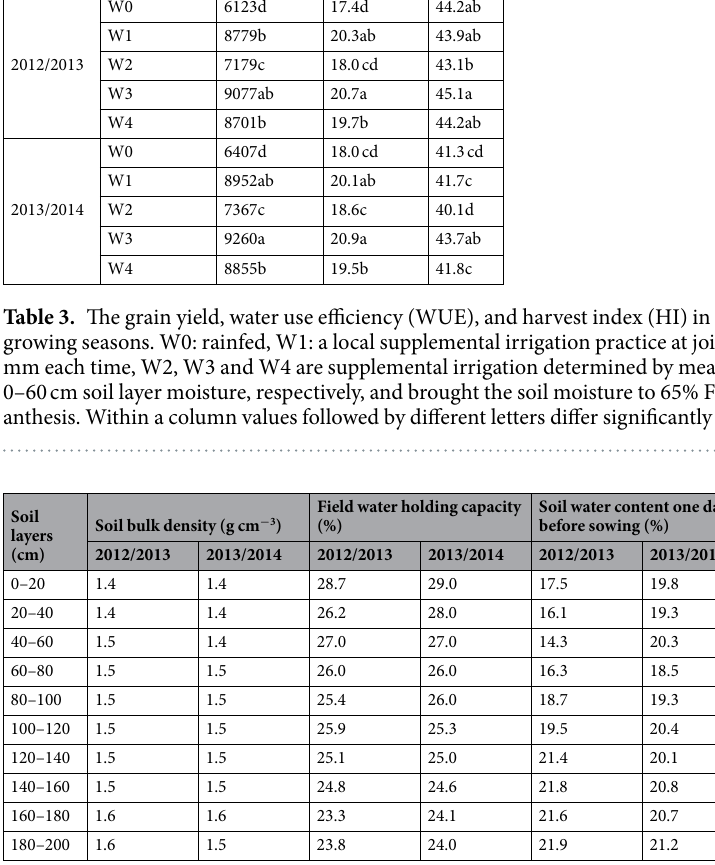
Table 4. Soil bulk density and soil water in the top 0–200 cm of the soil (in 20-cm increments) of the experimental